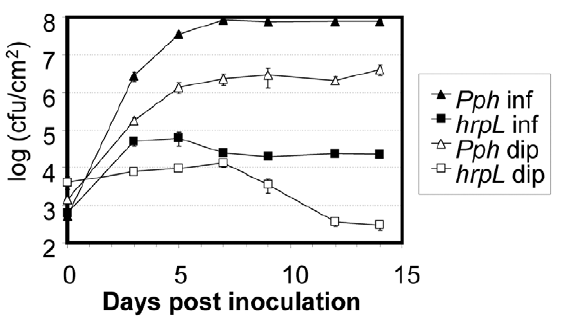
Figure 2. Growth curves of Pph 1448a and Pph D hrpL . Bacteria were inoculated either by infiltration with a bacterial suspension containing 5 6 10 4 cfu/ml or by dipping into a bacterial suspension containing 5 6 10 7 cfu/ml. Error bars represent standard error. Smallest error bars may be covered by the corresponding symbol.